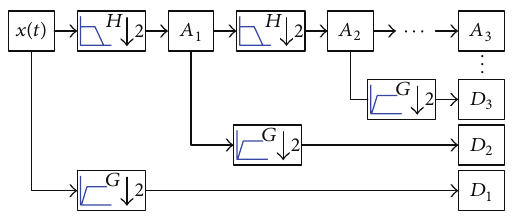
Figure 1: Decomposition procedure of 𝐽 -level